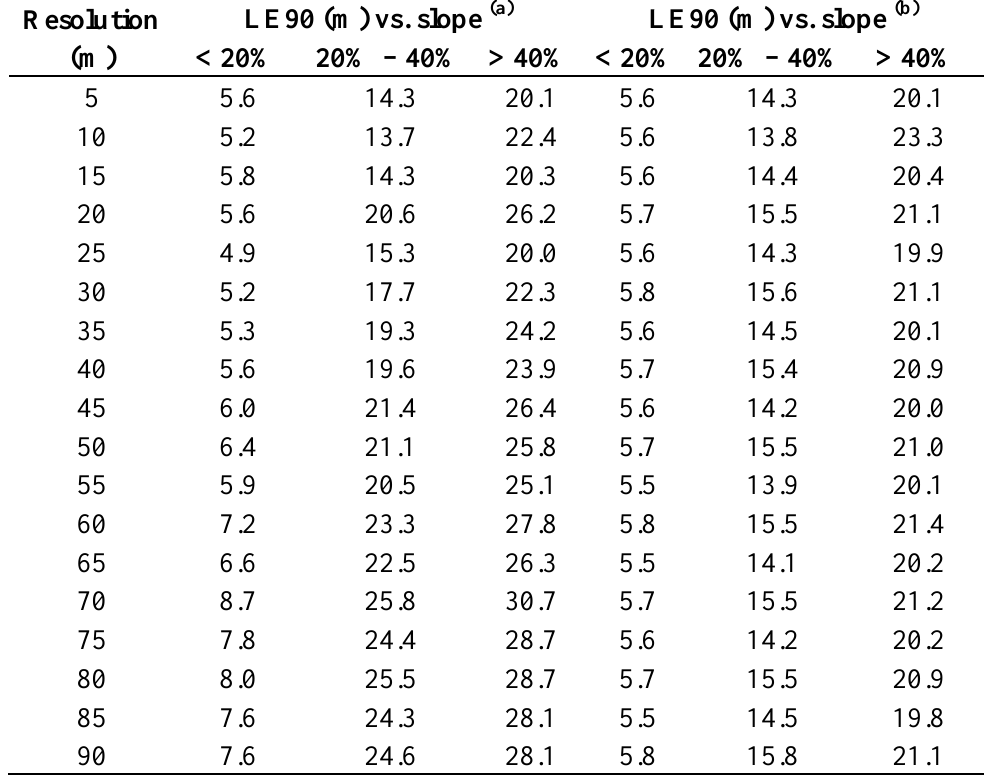
Table 1. Summary of residuals vs. slope for Cartosat-1 DSMs generated over Mausanne les Alpilles test site. (a) for DSMs generated at the desired resolution directly from the Cartosat-1 images. (b) for DSMs generated by downsampling the 5m resolution Cartosat-1 DSM. All values refer to a comparison over the whole test